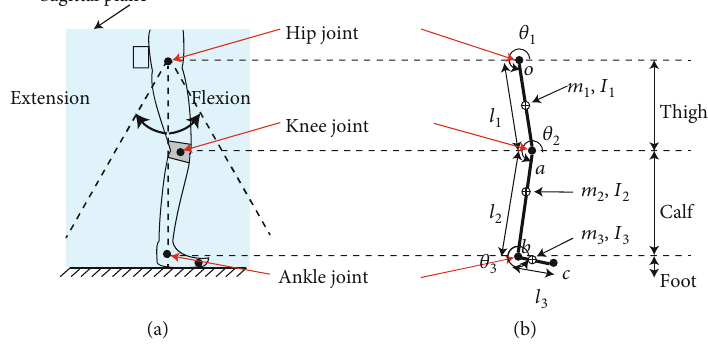
Figure 4: Two-dimensional kinematic model of a human